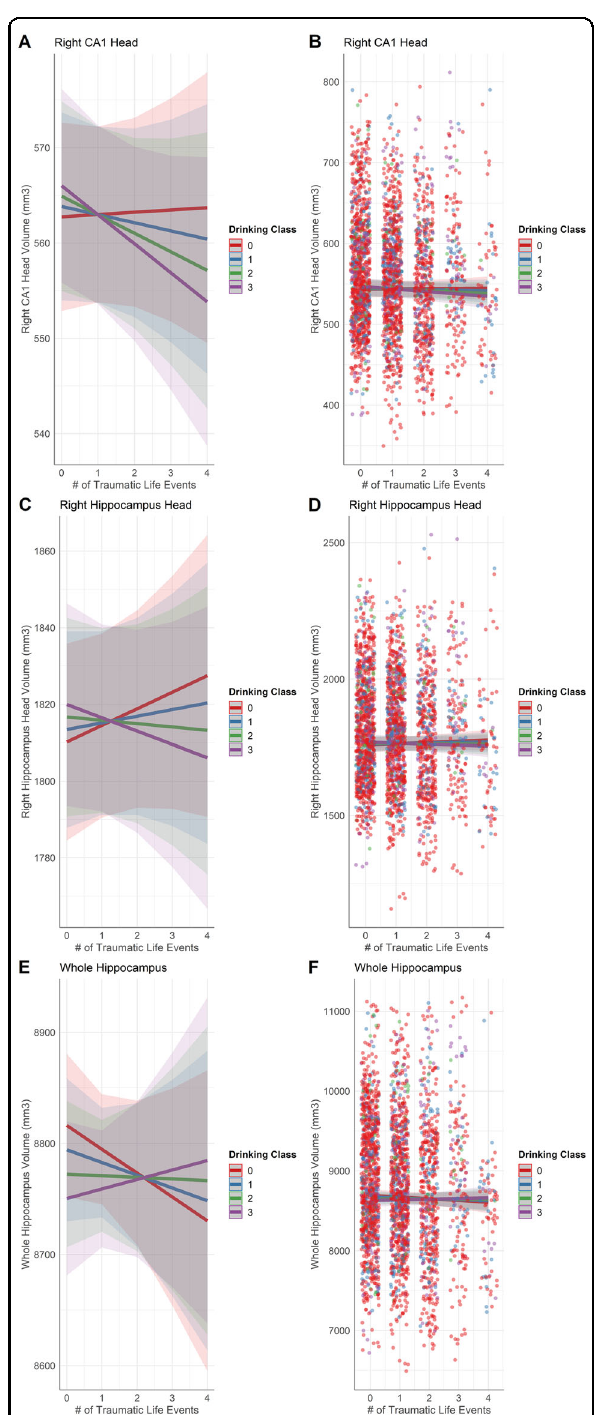
Fig. 4 Hippocampal sub fi eld volumes predicted by the interaction between lifetime trauma and drinking class (DrkClass). This interaction is represented for right CA1 head volumes ( A , B ), right hippocampus head volumes ( C , D ), and whole hippocampus volumes ( E , F ). Individual data points represent volume measured at subject scan visits. Lines represent the categorical values of the moderator variable, drinking